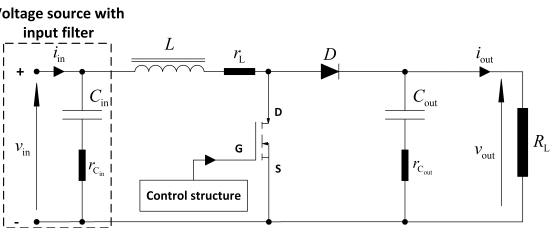
Figure 3. Extended, by input filter section, circuit diagram of a boost converter from Figure 1 used for control-to-output transfer function identification in simulation, P sim,est,c2o to an experimental setup shown in Figure 2